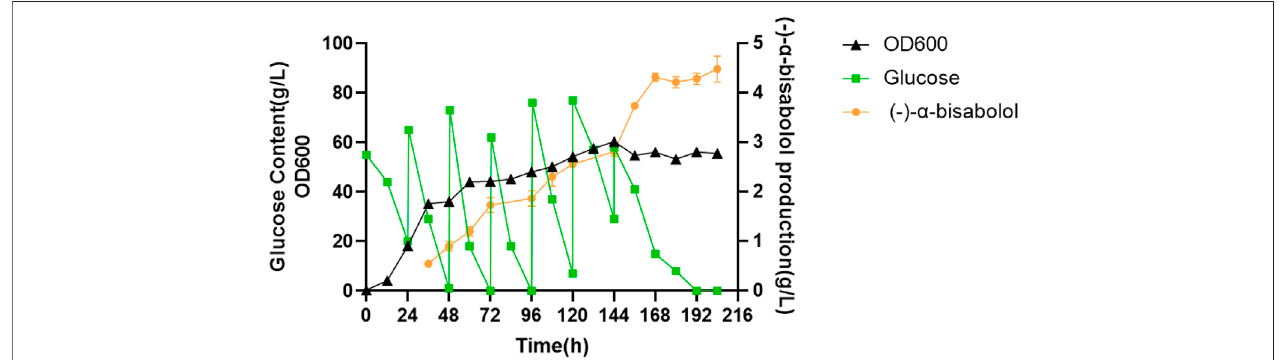
FIGURE 6 | Fed-batch bioreactor fermentation for (-)- α -bisabolol